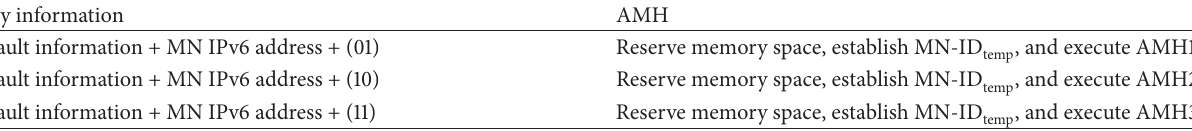
Table 1: Content of modified association request frame send by MN and AMH procedure process by next AP. Body information